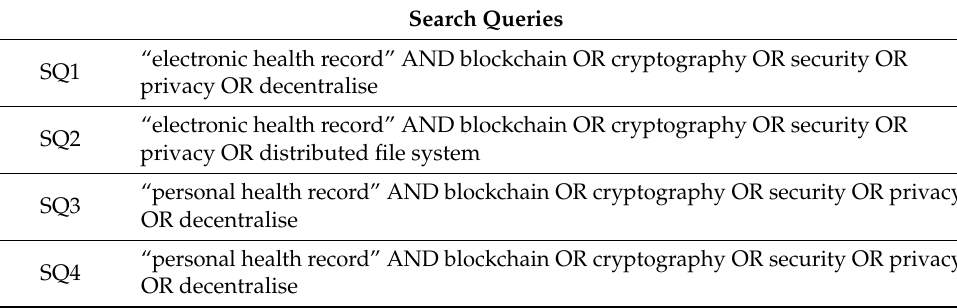
Table 2. Search queries used for the systematic